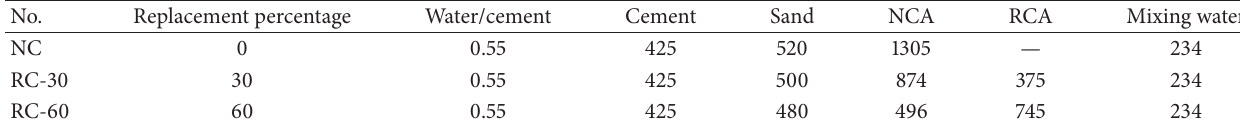
Table 2: Mix proportions of concretes (kg/m 3 ).